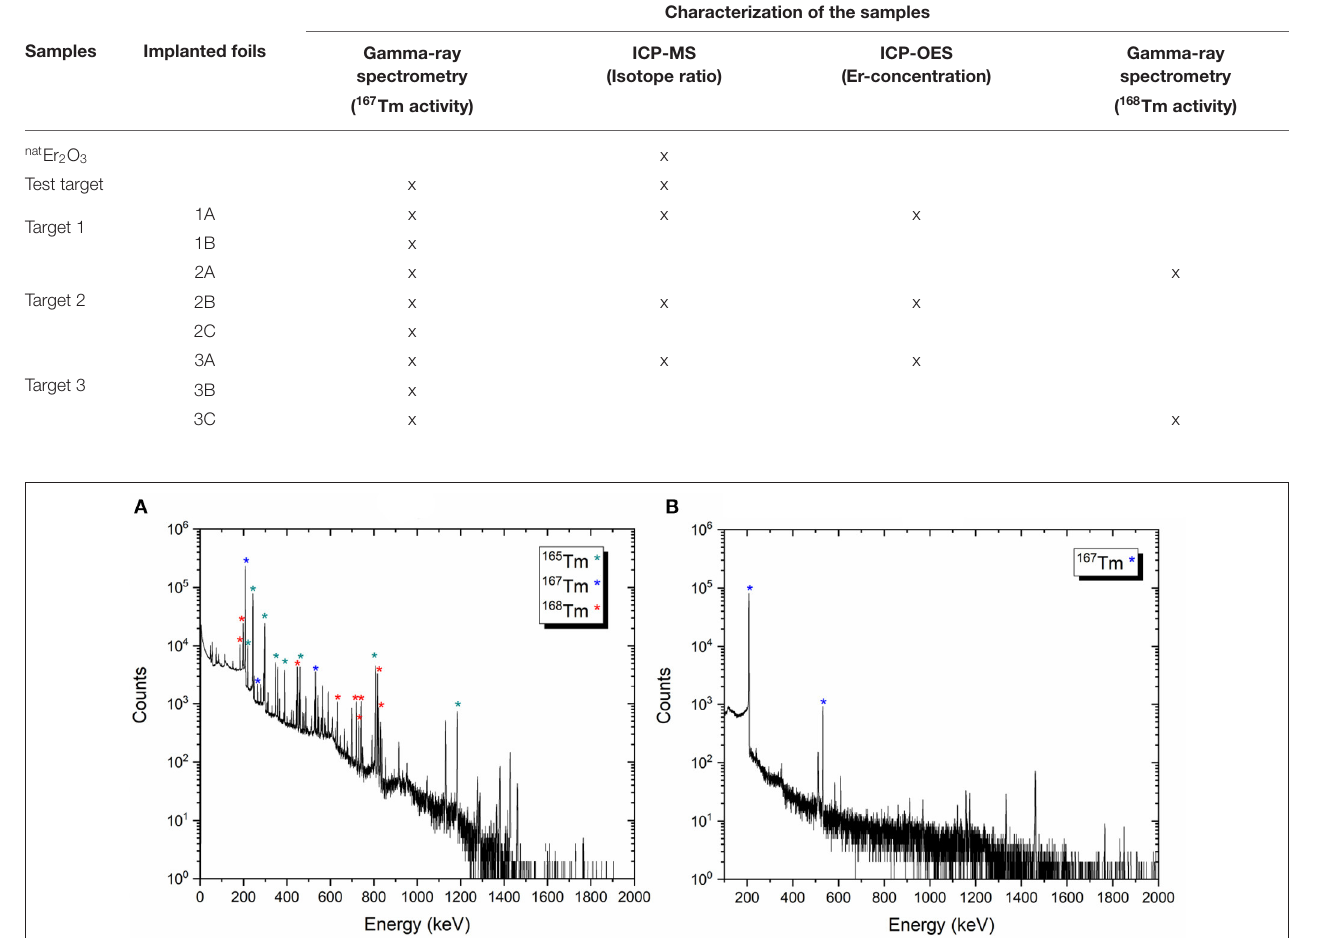
TABLE 2 | Overview of the characterization for different samples.